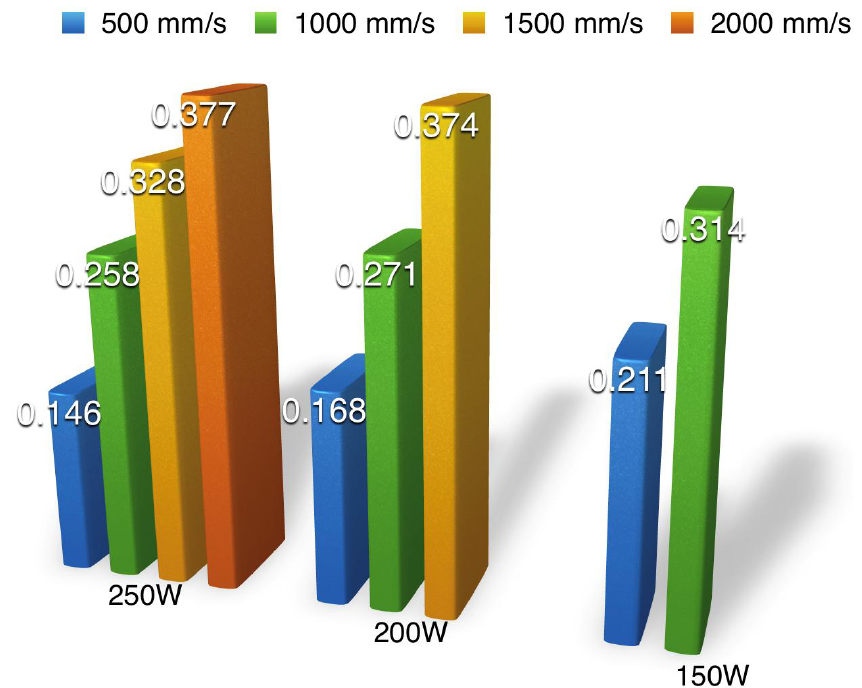
Figure 13. Cutting efficiency for full penetration. Figure 10. Cutting efficiency for full